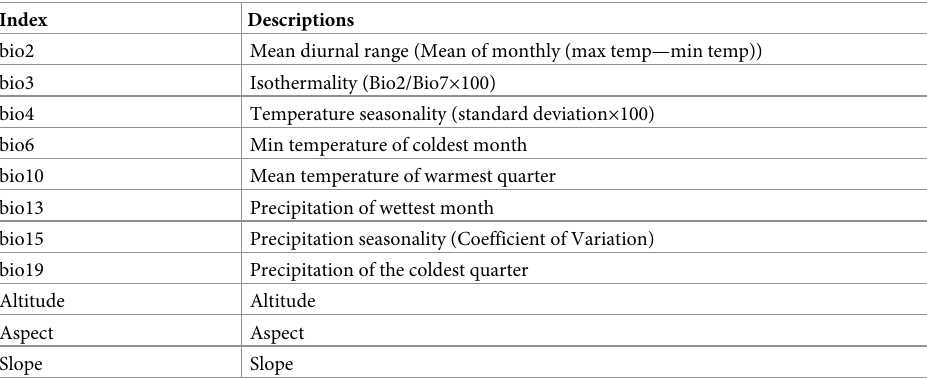
Table 1. Environmental variables used in MaxEnt model.